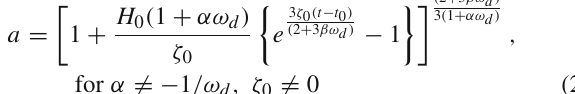
Fig. 1 The scale factor evolution for different values of ζ 0 > 0 with H 0 = 1, ω d = − 0 . 5, α = 0 . 8502 and β = 0 . 4817